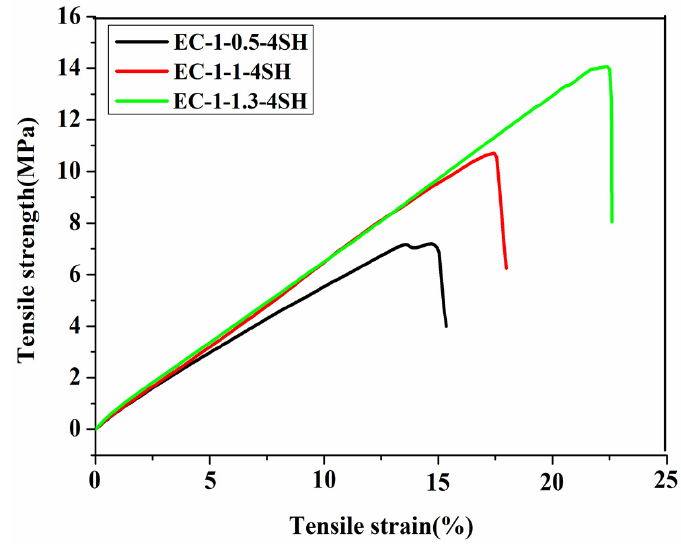
Figure 15. Tensile stress and strain of the EC cross − linked polymers using pentaerythritol tetra(3 − mercaptopropionate) as the cross − linker.